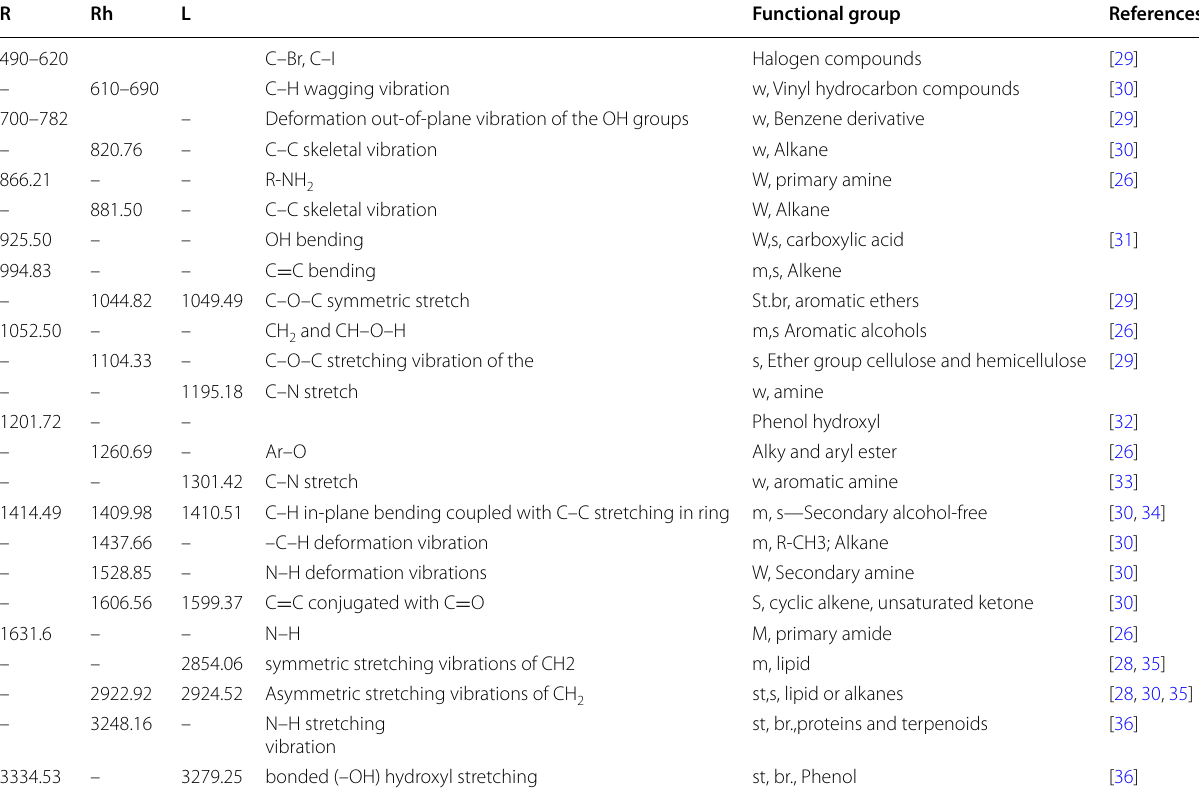
Table 2 FT-IR spectral assignment and functional groups of R, Rh, and L crude alcoholic extract